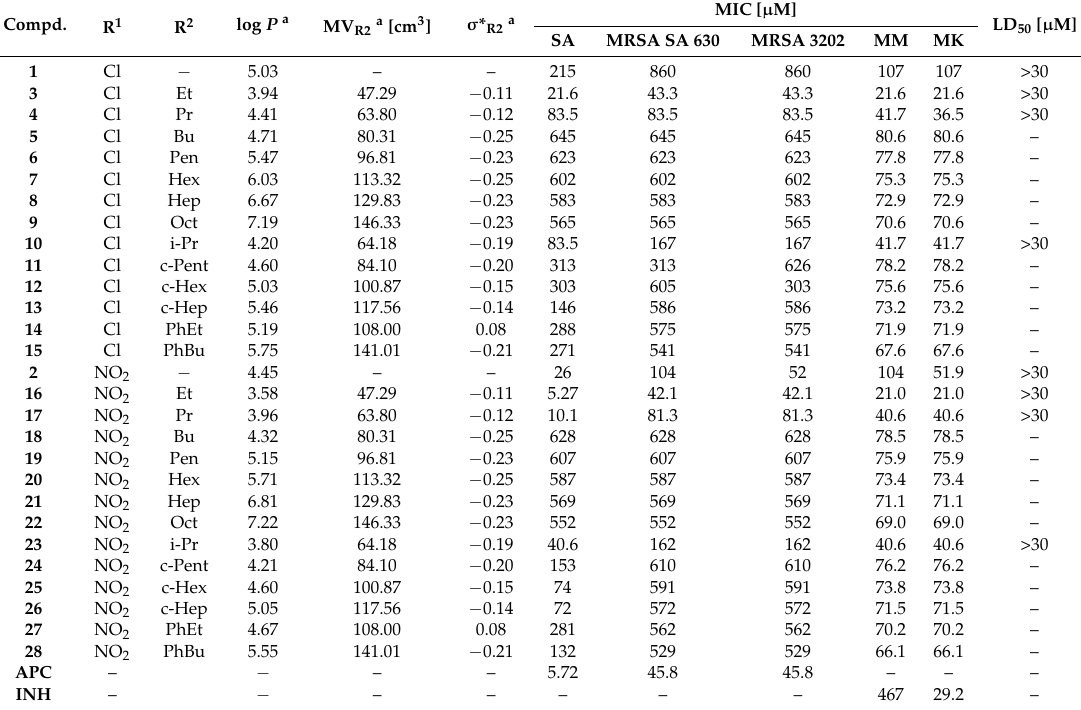
Table 1. Structures of the discussed anilides 1 , 2 and carbamates 3 – 28 ; calculated values of log P